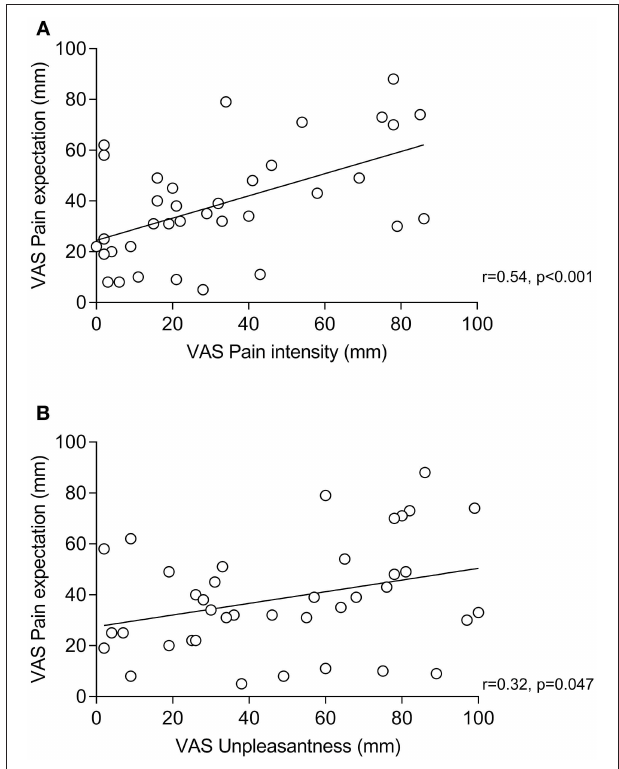
FIGURE 2 | Correlations (Pearson’s r) between pain expectation and perceived pain intensity (A) and pain expectation and perceived pain unpleasantness (B) within groups receiving positive treatment suggestions (i.e., placebo